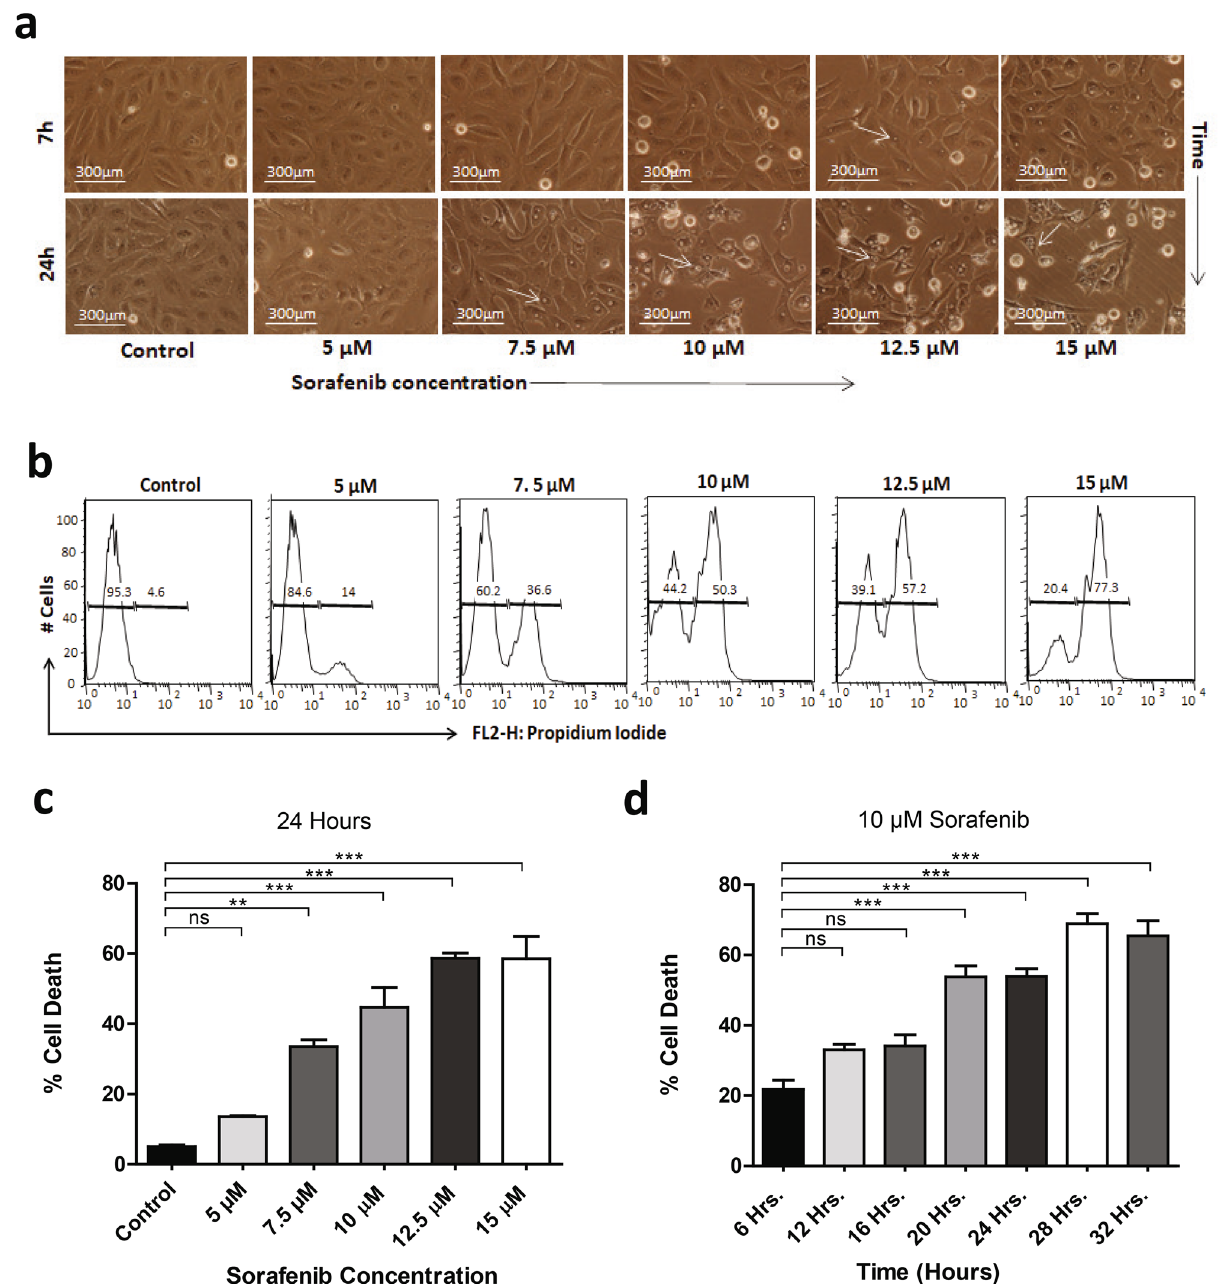
Figure 1. Sorafenib suppress hepatic stellate cell viability and induce cellular death with cytoplasmic vacuolation depending on dose and duration of treatment. ( a ) Phase-contrast microscope showing the LX2 cells treated with different concentration of sorafenib (2.5 µM, 5 µM, 7.5 µM, 10 µM and 15 µM) in 7 h and 24 h in compare with untreated control cells. Cytoplasmic vacuoles were indicated by white arrow. Images were taken using × 20 objective, scale bar: 300 μm. ( b ) Cell death and viability of LX2 cells were shown with propidium iodide (PI) positive and negative populations of LX2 cells after treatment of different concentration of sorafenib for 24 h using flow cytometry. ( c ) The quantification of dose and time dependent percentage (%) cell death of LX2 cells with sorafenib treatment were measured. The bars represent mean ± s.d. from three independent experiments (ns > 0.05, *P < 0.05; **P < 0.01; ***P < 0.001 One-way analysis of